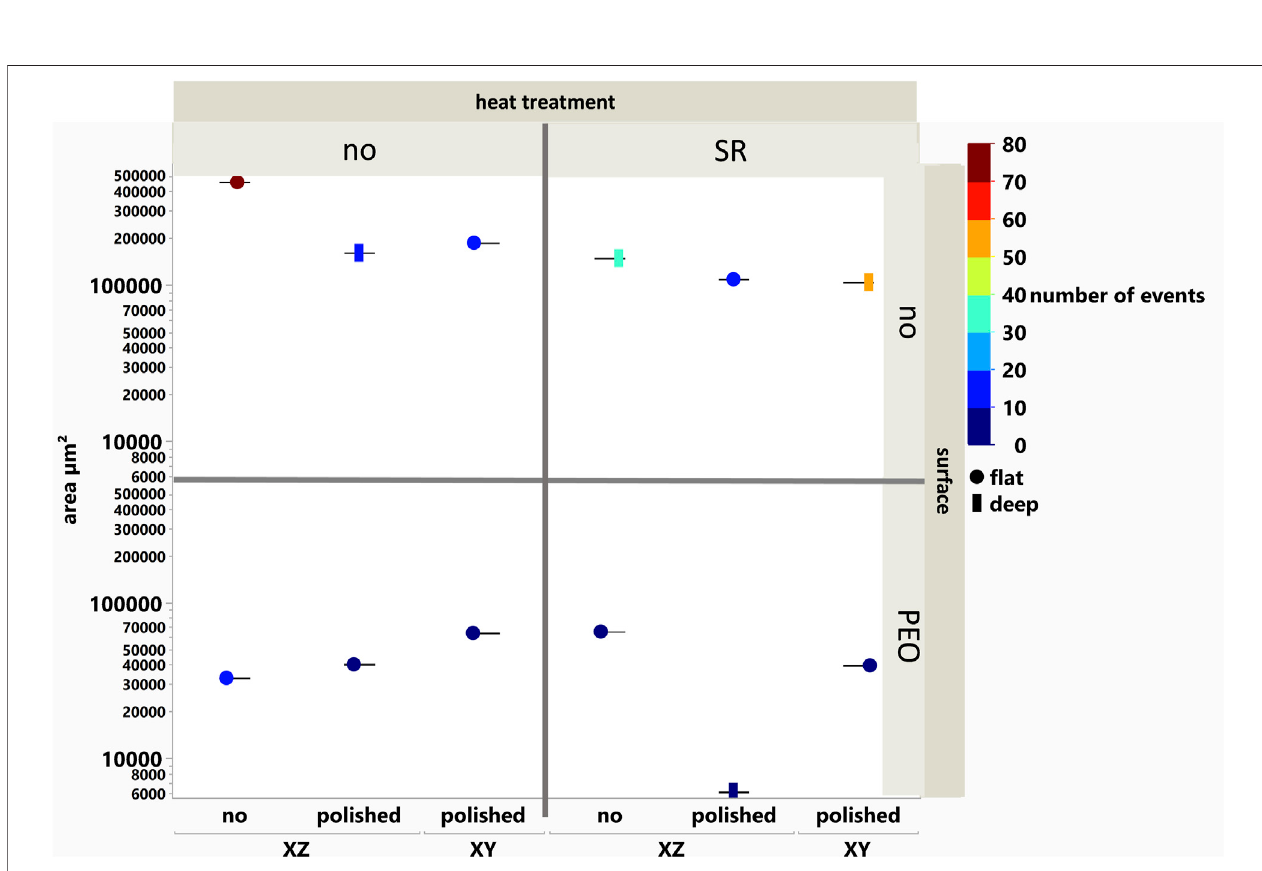
FIGURE 7 | Corroded area in the cross-sections of long-term immersed samples vs the printed direction, mechanical, heat, and chemical surface treatment.